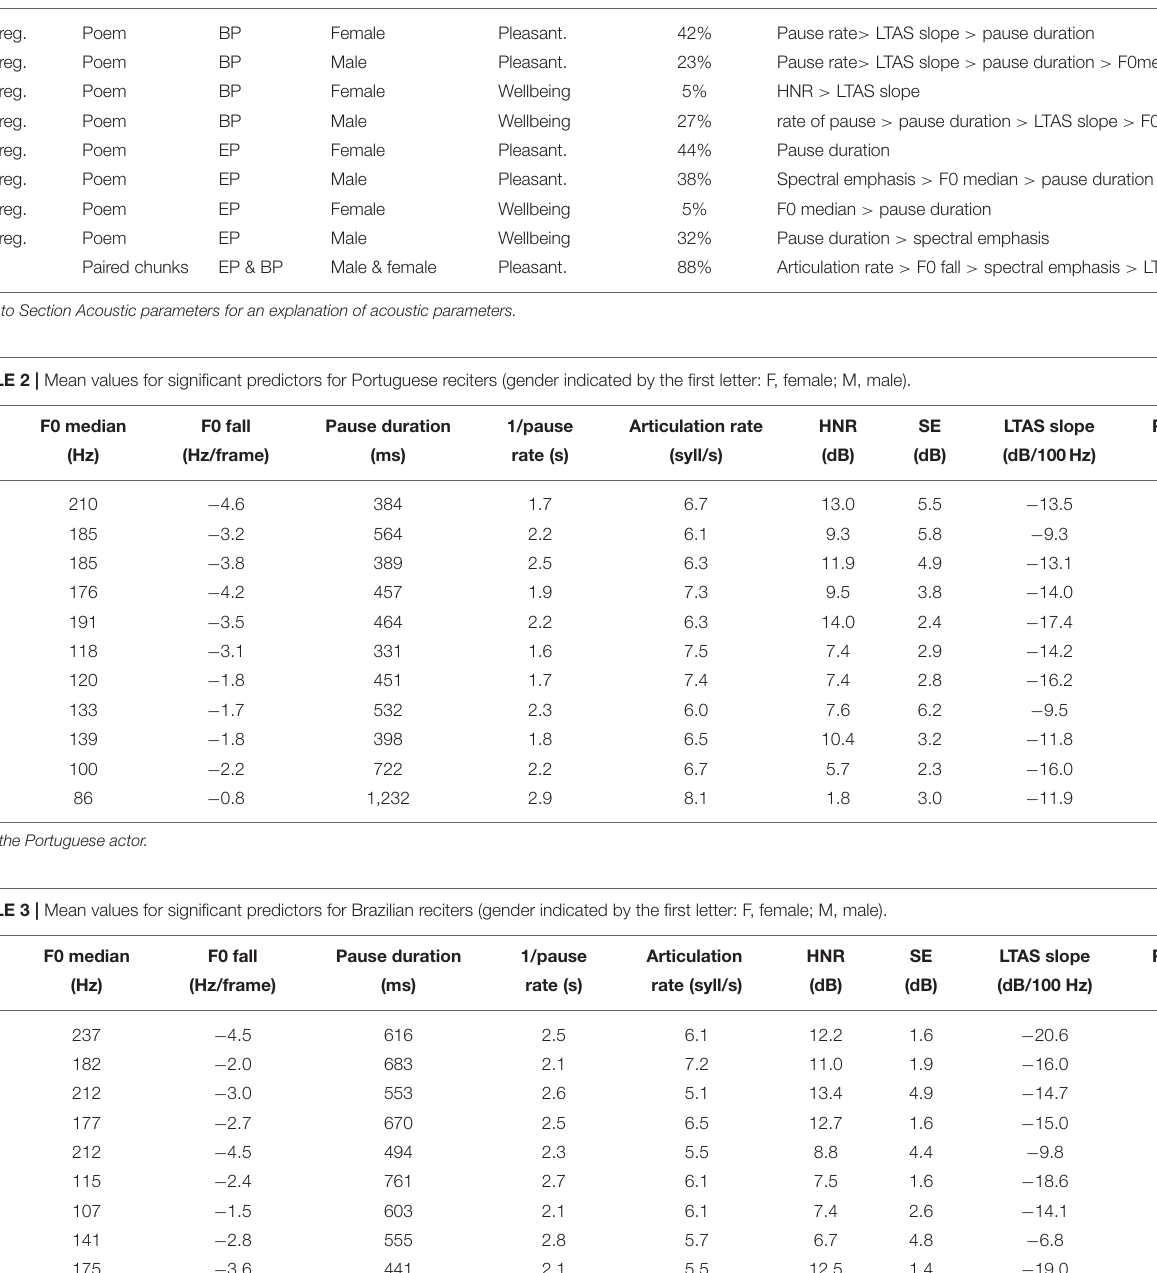
TABLE 1 | Statistical models’ summary. “Log. reg.” stands for “logistic regression,” and “pleasant.” stands for “pleasantness.” Model type Dataset